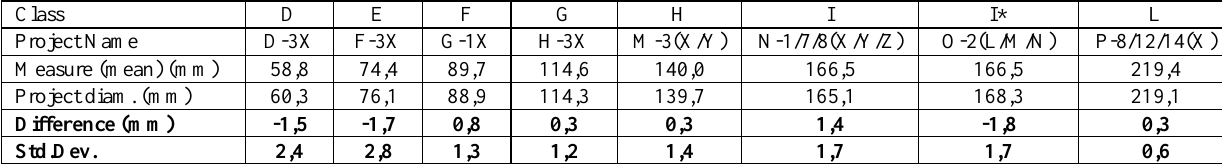
Table 1: Table comparing surveyed data to project data.